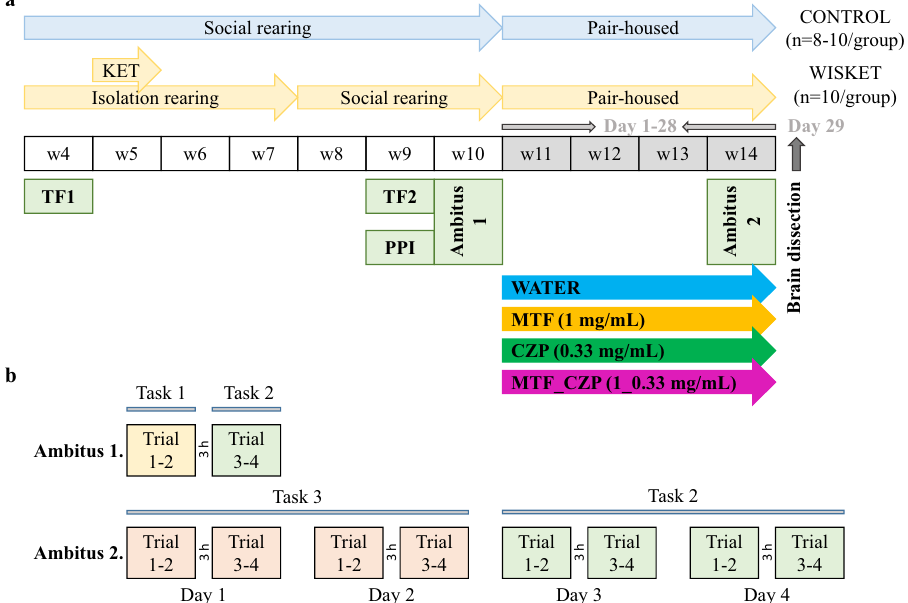
Figure 1. Experimental paradigm ( a ). Abbreviations: w, age in weeks; KET, ketamine; TF, tail-flick test; PPI, pre-pulse inhibition test; MTF, metformin; CZP, clozapine. Experimental paradigm in the Ambitus system ( b ). The Trial 1 and Trial 2 (also Trial 3 and Trial 4) were repeated at intervals of 1 min, with an interval of 3 h between Trial 2 and Trial 3. The means of 4 trials/day were analyzed for the Ambitus test and are referred to as Day 1–4 in Fig. 3. The background color of the trials refers to the Task applied, as follows. Task 1 (yellow): all of the inside and outside boxes were baited (16 rewards); Task 2 (green): the inside boxes alone (8 rewards) were baited; and Task 3 (peach): the outside boxes alone were baited (8